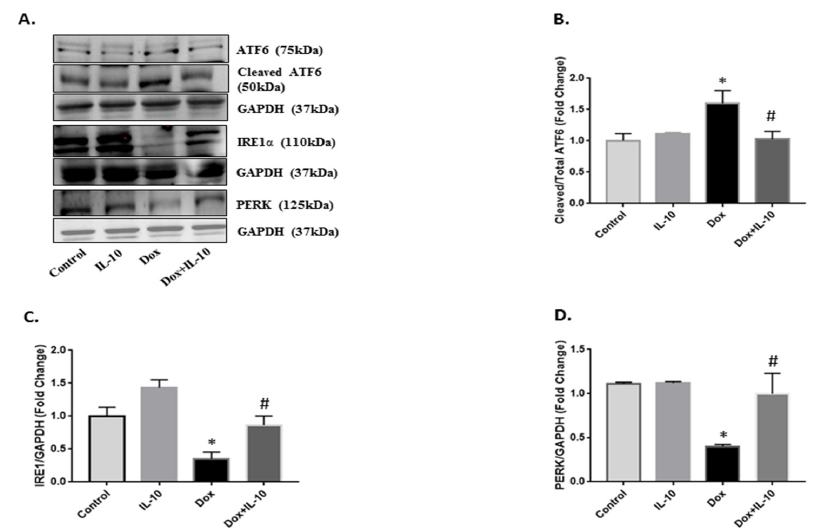
Figure 3. IL-10 effect on Dox-induced changes in UPR-signaling transducers. Expression of UPR-signaling transducers in isolated cardiomyocytes treated with Dox (5.43 µg/mL) in the presence or absence of IL-10 (10 ng/mL) for 24 h. ( A ) Western blot of respective proteins using activating transcription factor 6 α (ATF6 α ) (1:1000), inositol-requiring kinase 1 α (IRE1 α ) (1:2000), and protein kinase-like endoplasmic reticulum kinase (PERK) (1:500) antibodies. GAPDH was used as a loading control. Densitometric analysis of respective proteins ( B ) ATF6; ( C ) IRE1 α ; and ( D ) PERK. GAPDH was used as the loading control except for ATF6. Data are means +/ − SE from 3 individual experiments. * p < 0.05 vs. control, IL-10; # p < 0.05 vs. Dox.